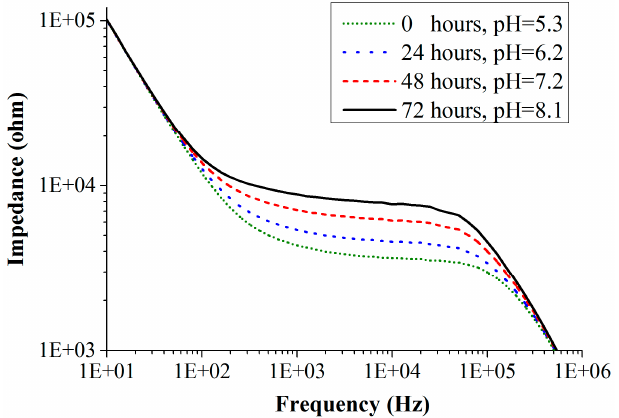
Figure 9. Impedance spectra of the mold sensor recorded during the growth of Eurotium amstelodami mold species measured with CF-electrodes.